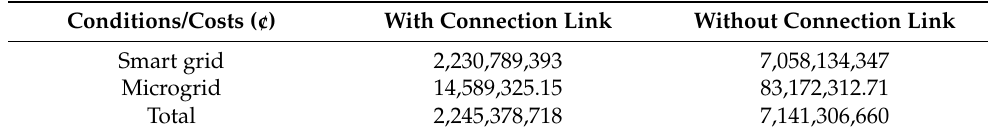
Table 5. Comparison among different conditions for uncertainty